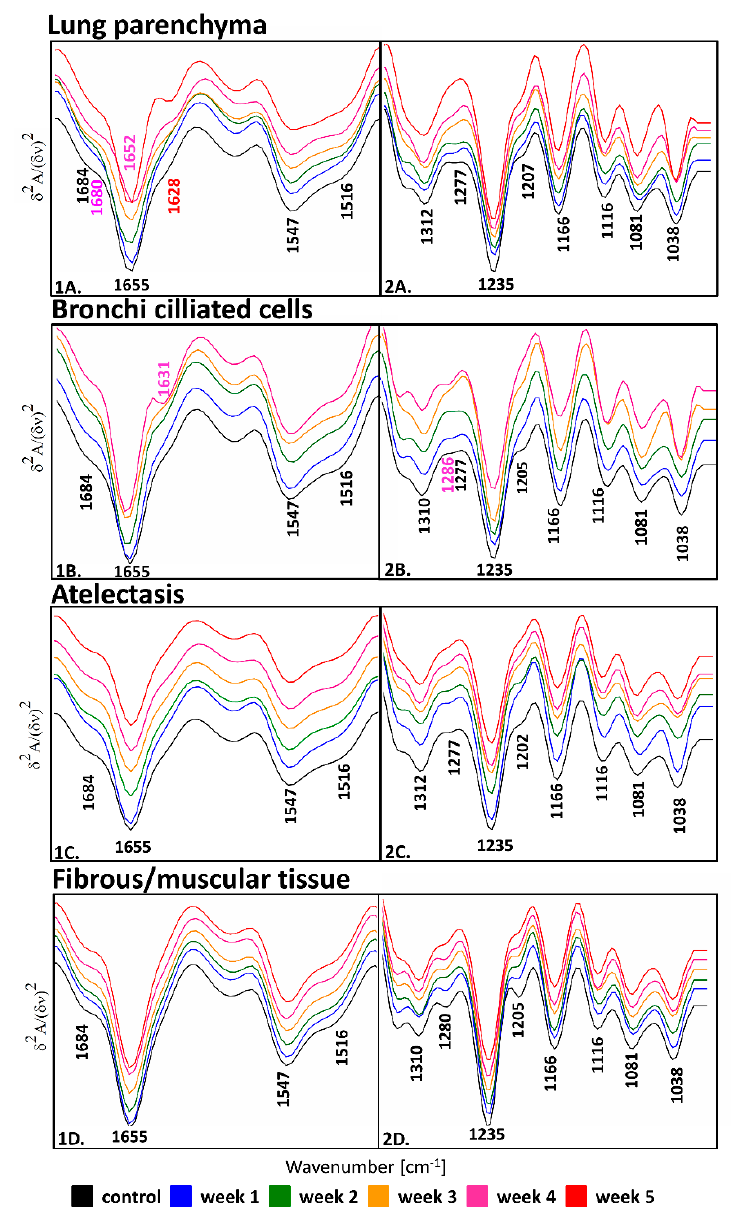
Figure 2. The comparison of second derivative IR spectra extracted from UHCA analysis for lung parenchyma (averaged from n = 37 spectra) ( A ), bronchi ciliated cells (averaged from n = 23 spectra) ( B ), atelectasis (averaged from n = 43 spectra), ( C ) and fibrous / muscular tissue (averaged from n = 44 spectra) ( D ). Spectra are shown in the regions of 1700–1480 ( 1 ) and 1340–1000 cm − 1 ( 2 ). On week 5, bronchi ciliated cells were not found since atelectasis covers the entire area of the